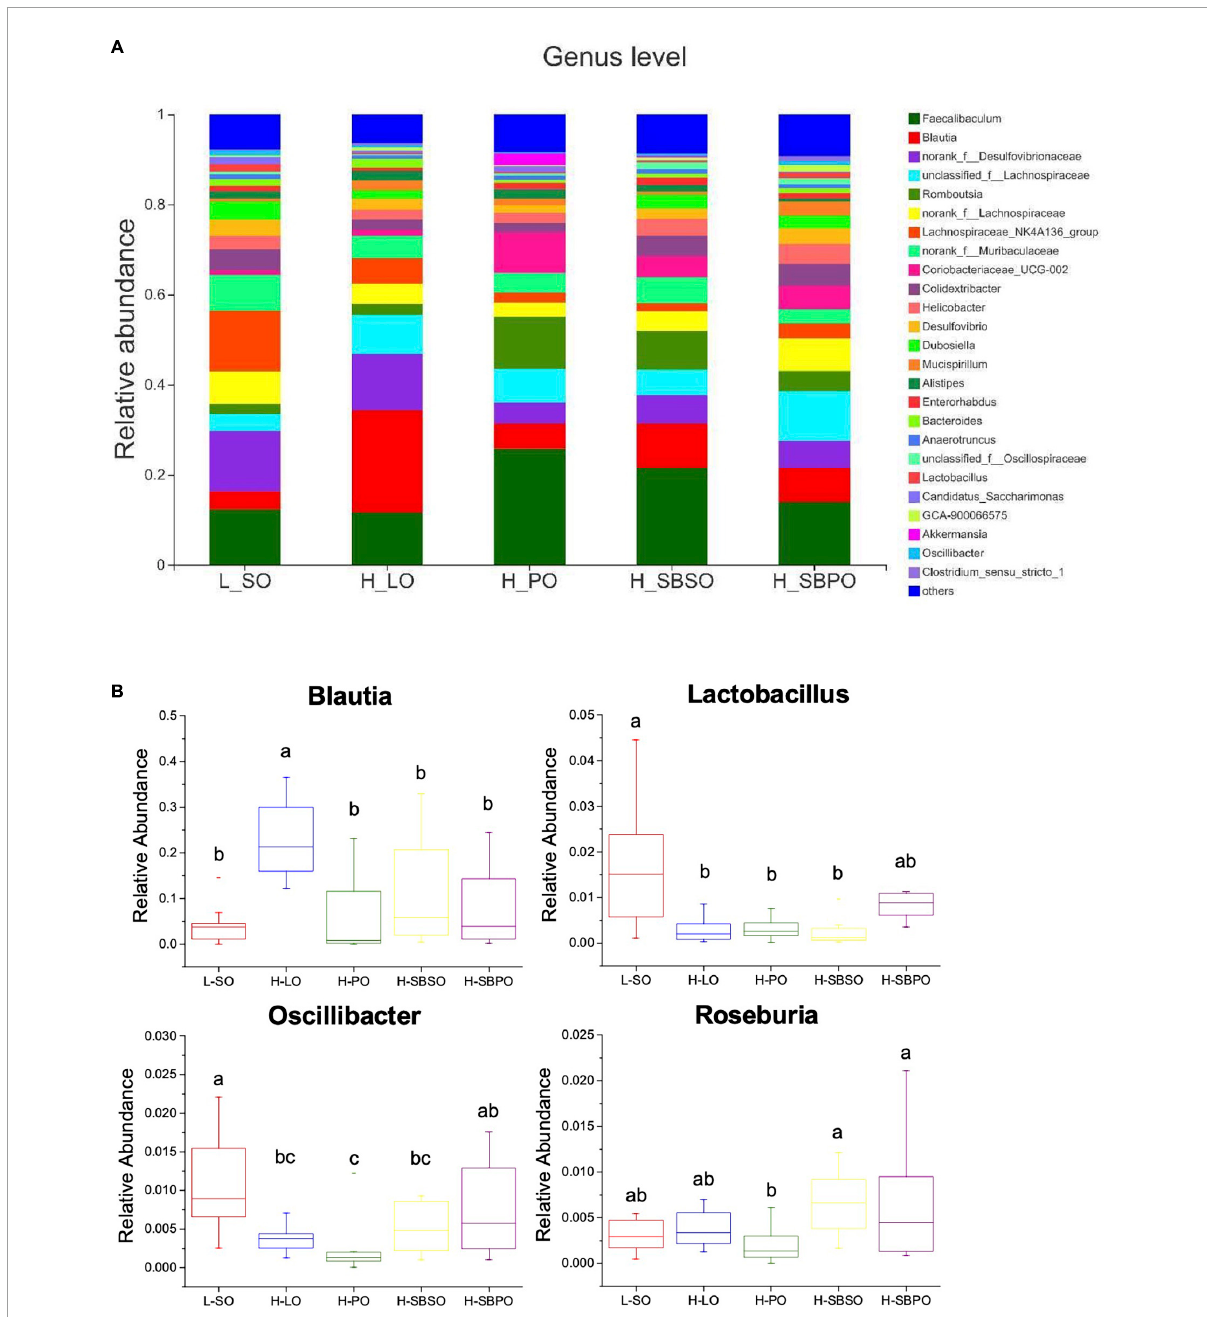
FIGURE6 (A) Bacterial taxonomic profile ( > 0.01%) of gut microbiota at genus level. (B) The relative abundance of Blautia , Lactobacillus , Oscillibacter, and Roseburia at the genus level ( n = 11–12). L-SO, low-fat diet with soybean oil; H-LO, high-fat diet with lard oil; H-PO, high-fat diet with peanut oil; H-SBSO, high-fat diet with sea buckthorn seed oil; H-SBPO, high-fat diet with sea buckthorn pulp oil. Different letters (a, b, and c) indicate significant differences ( P < 0.05) in the relative abundance of Blautia , Lactobacillus , Oscillibacter, and Roseburia between each other.